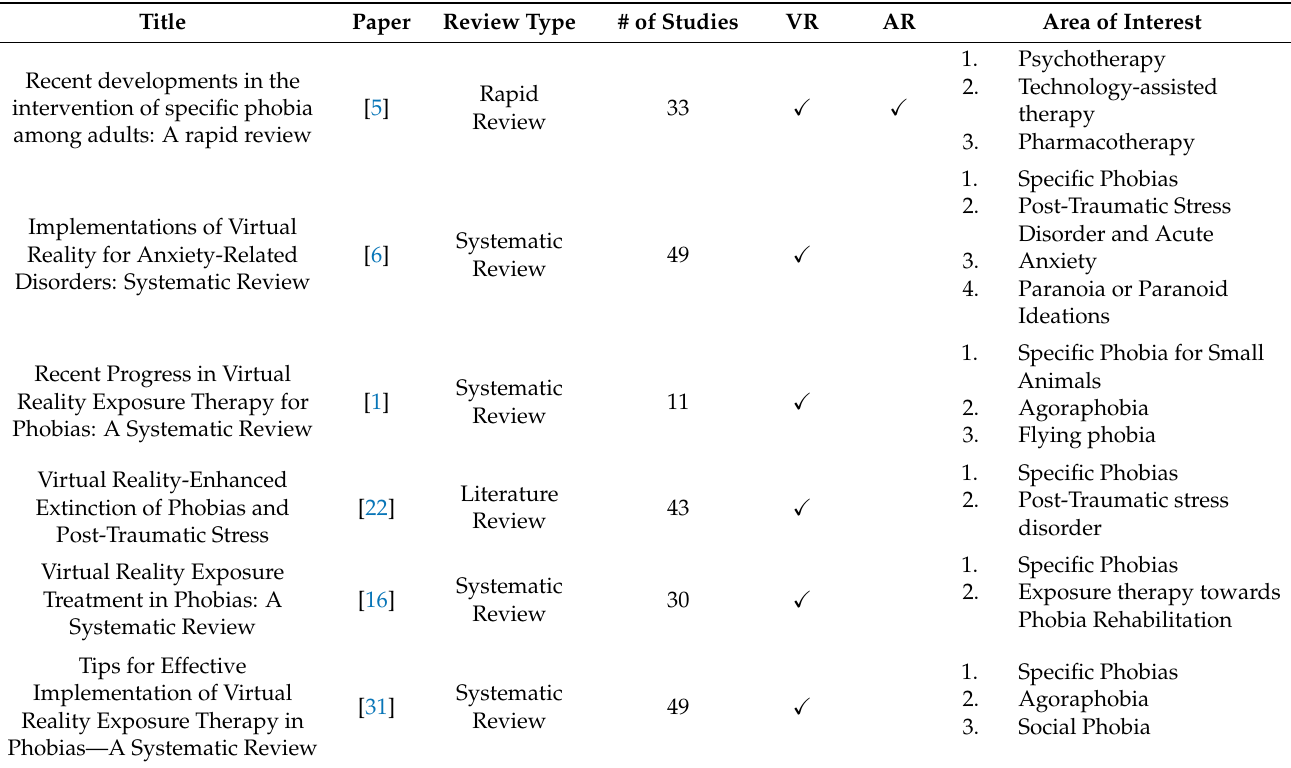
Table 1. Existing review papers on anxiety disorder exposure therapy.